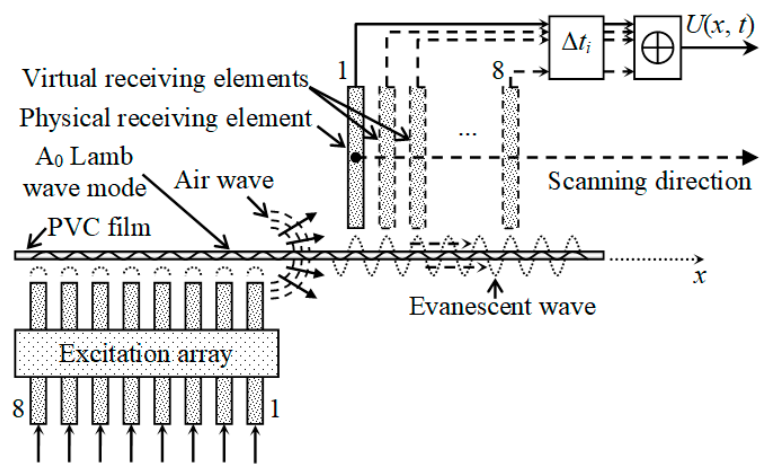
Figure 21. Reception of subsonic A 0 mode by virtual receiving